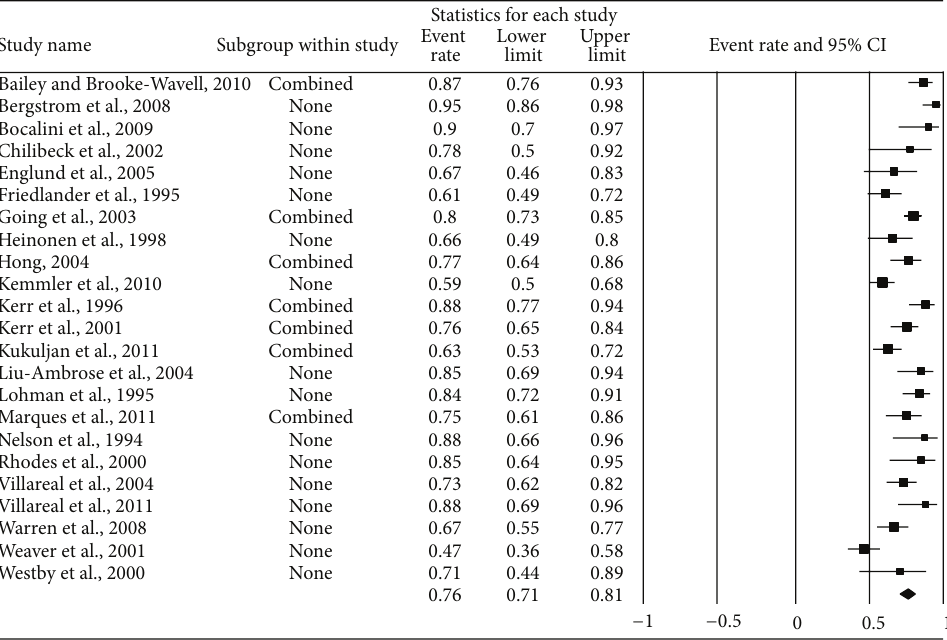
Figure 10: Forest plot for compliance (study level). Forest plot for compliance at the study level. The black squares represent the mean event rate while the left and right extremes of the squares represent the corresponding 95% confidence intervals. The middle of the black diamond represents the overall mean event rate while the left and right extremes of the diamond represent the corresponding 95% confidence intervals.